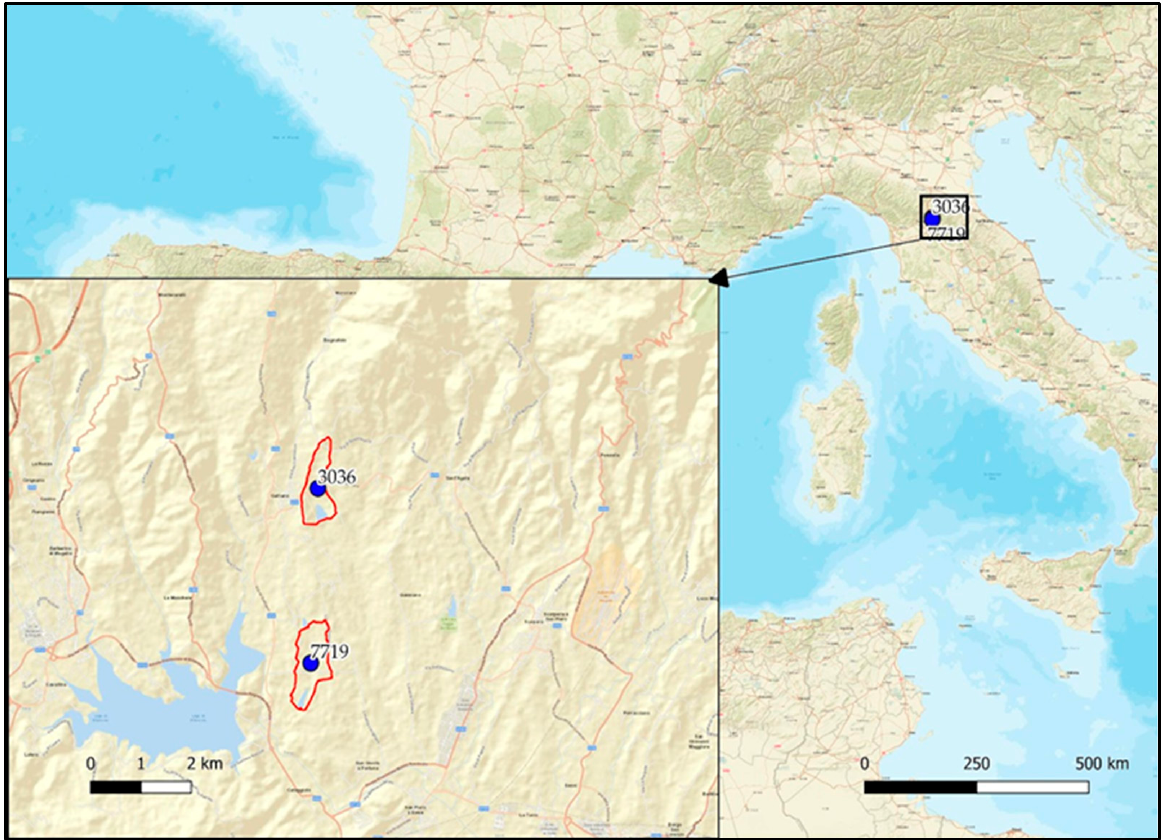
Figure 1. Geographical position of the two basins analyzed.